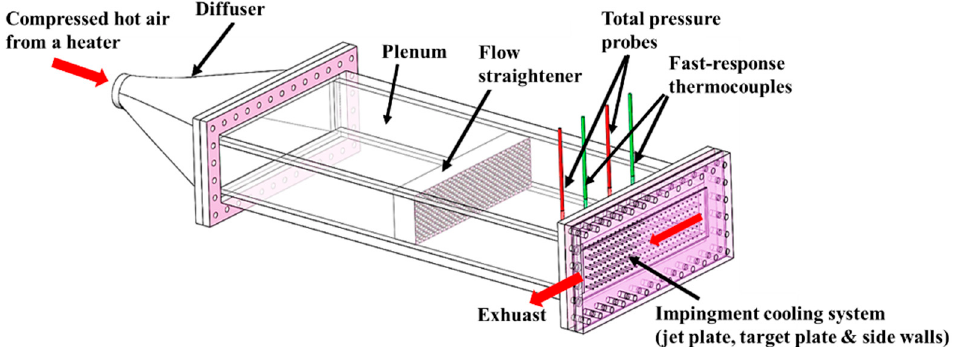
Figure 2. Schematic of the experimental test section.